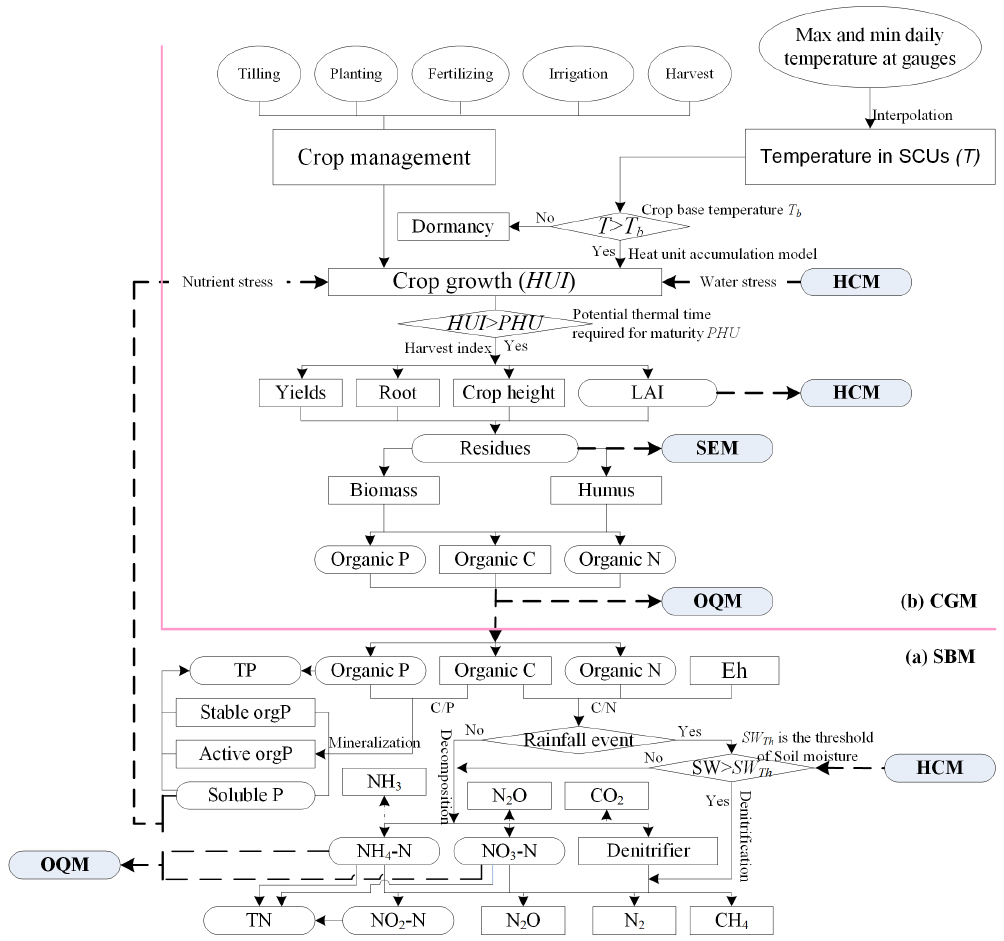
Figure 3. The flowchart of SBM (a) and CGM (b) in the ecological part and the interactions with other